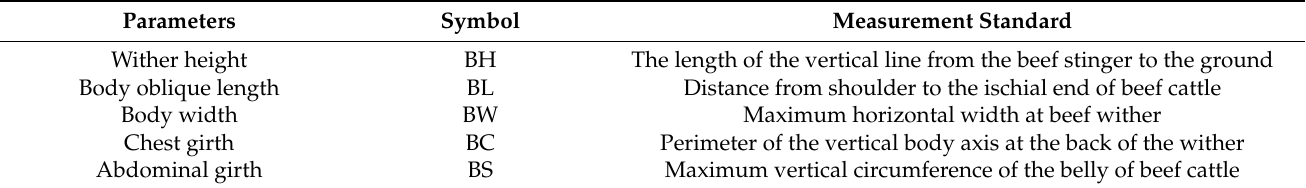
Table 1. The assessment criteria of beef cattle body dimensions.